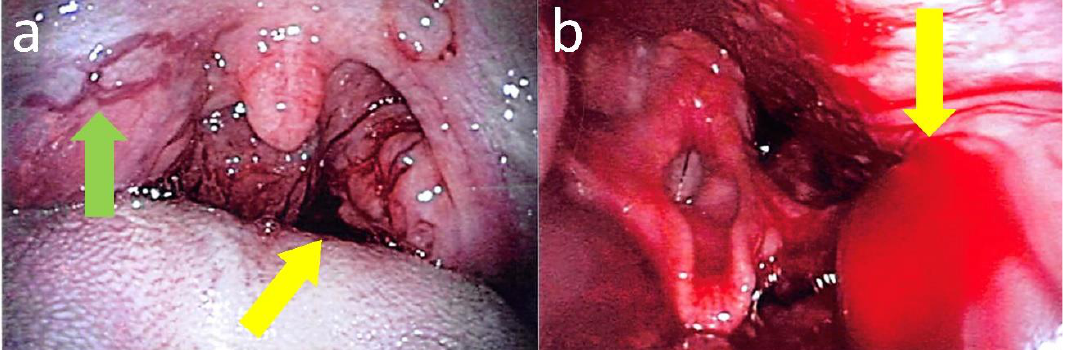
Figure 1. ( a ) Pharyngeal fiberoptic findings at the time of presentation. The yellow arrow indicates slight bleeding of the pharynx. The green arrow indicates varicose veins of the right soft palate. ( b ) Laryngeal fiberoptic findings during hematemesis. The yellow arrow indicates active bleeding from the posterior part of the left tonsil.